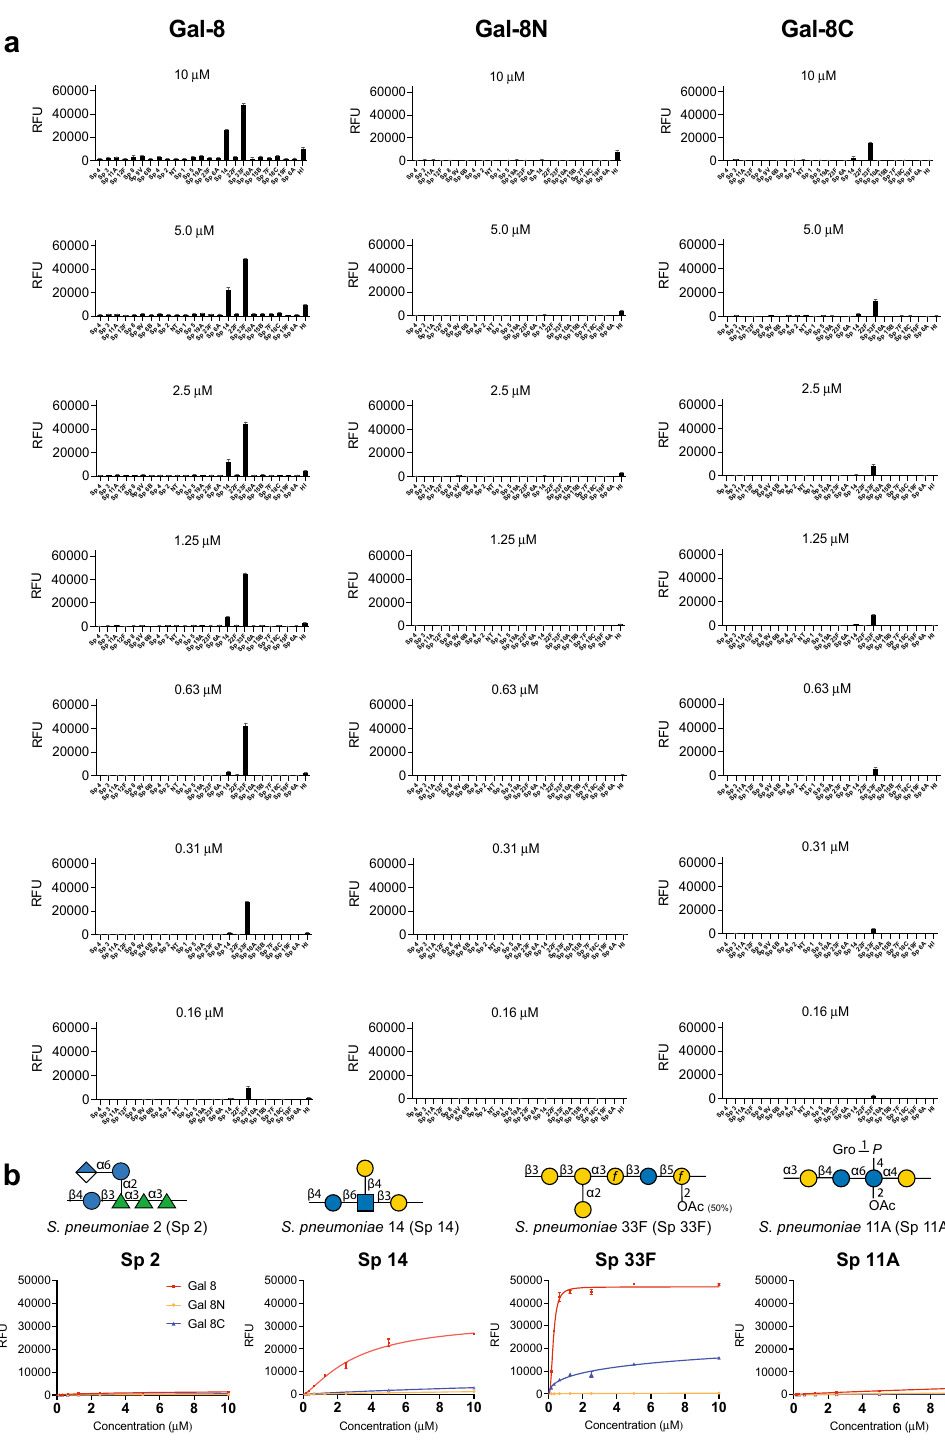
Figure 5. Gal-8 recognize specific strain of S. pneumoniae that express self-like antigens on the MMA. ( a ) MMA was incubated with Gal-8, Gal-8 N and Gal-8C at the concentrations indicated. HI: Haemophilus influenzae. Error bars represent means ± standard deviation (SD). RFU, relative fluorescence units. ( b ) Selected serotypes of S. pneumoniae represented on the MMA were shown with binding isotherms. Microbial glycan structures for each respective microbe are shown. Error bars represent means ±